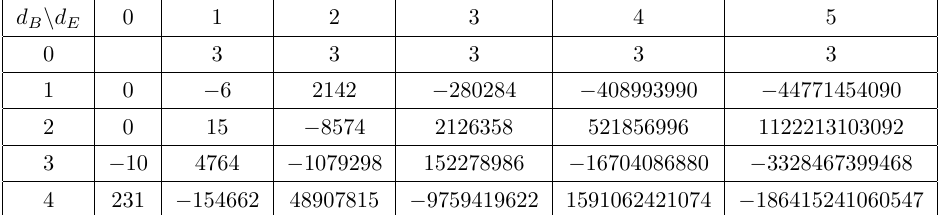
Table 5 . The refined GV numbers n g L ,g R